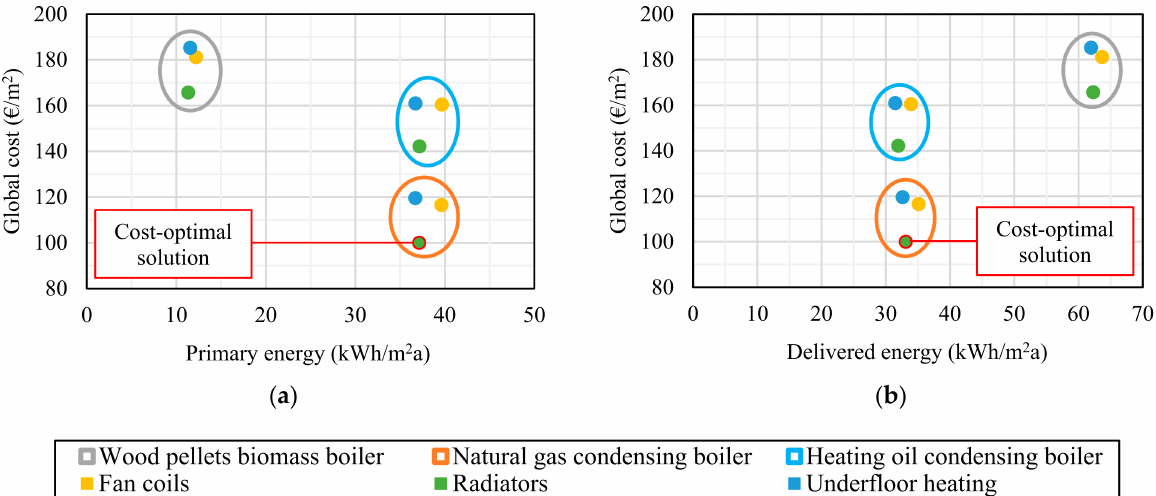
Figure 11. Results from cost-optimal energy analysis—the ratio of global cost, ( a ) primary energy, ( b ) delivered energy reduced to a unit of building area.